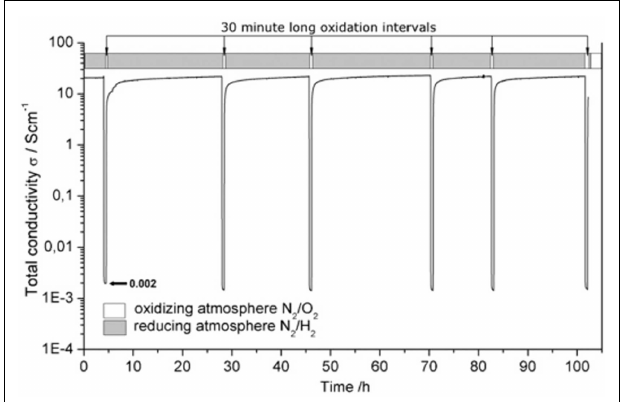
FIGURE 7 |Thermal and chemical expansion behaviors of Sr 0.93 Y 0.07 TiO 3 /YSZ (65/35vol%) ceramic composite .The sample was first heated up to 1060°C and cooled down to 820°C in Ar, then subjected to two redox cycles between wet Ar/4% H 2 and Ar/20% O 2 at 820°C, and finally cooled down to room temperature (Fu et al., 2007). Reprinted with permission from